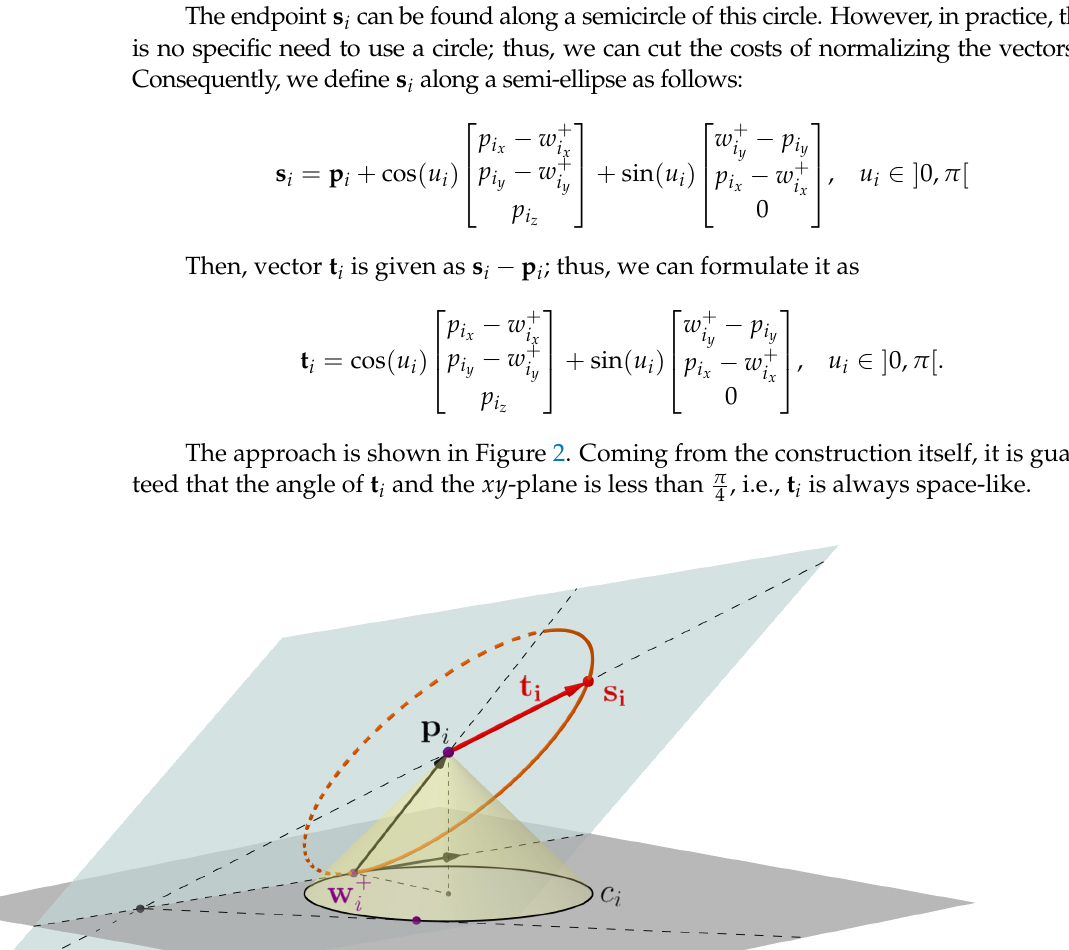
, which leaves the i